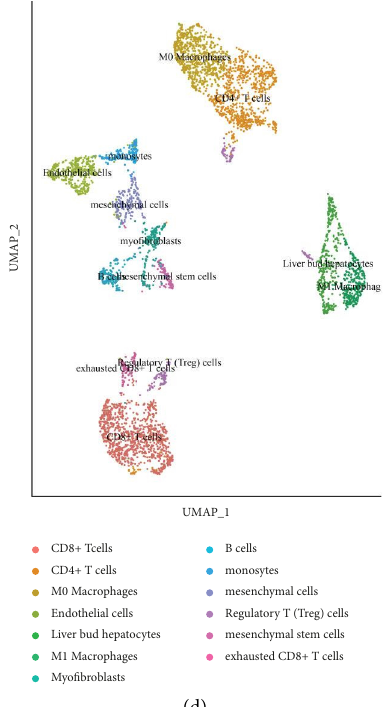
Figure 8: (a) Te ElbowPlot function is used to evaluate PCs. (b) A visual representation of JackStrawPlot, which compares P -value distributions for PCs to a uniform distribution. (c) Cell groups are represented by diferent numbers or colors when using UMAP or TSNE methods. (d) Cell populations are represented on the map by diferent numbers or colors after they have been manually